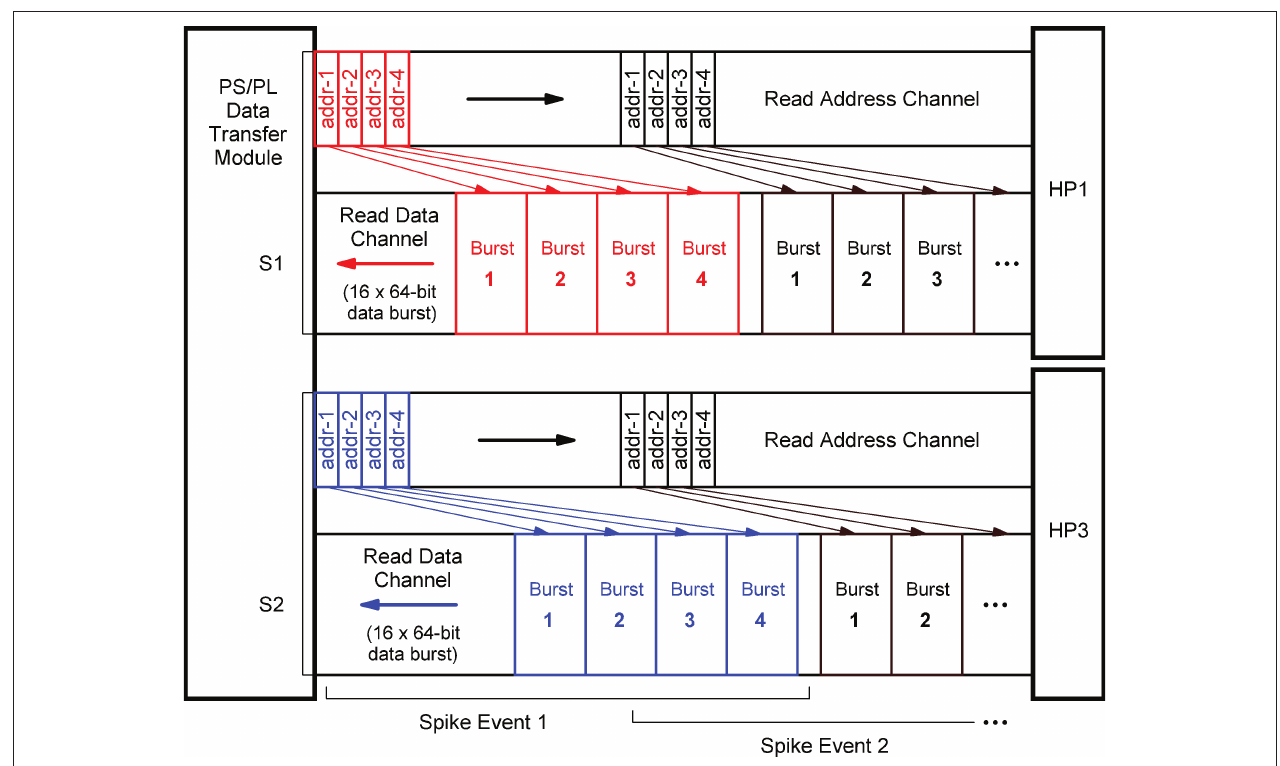
FIGURE 9 | AXI stream protocol implementation. To create data streams that are as continuous as possible, data transfers are already scheduled without waiting for the preceding transfer to complete. Per spike event, the transfer of a sequence of four data bursts is initiated on each of the two read data channels associated with the two streams S1 and S2 (marked red and blue). For this purpose, the memory read base addresses of the four burst data packets are transmitted as a block on the read address